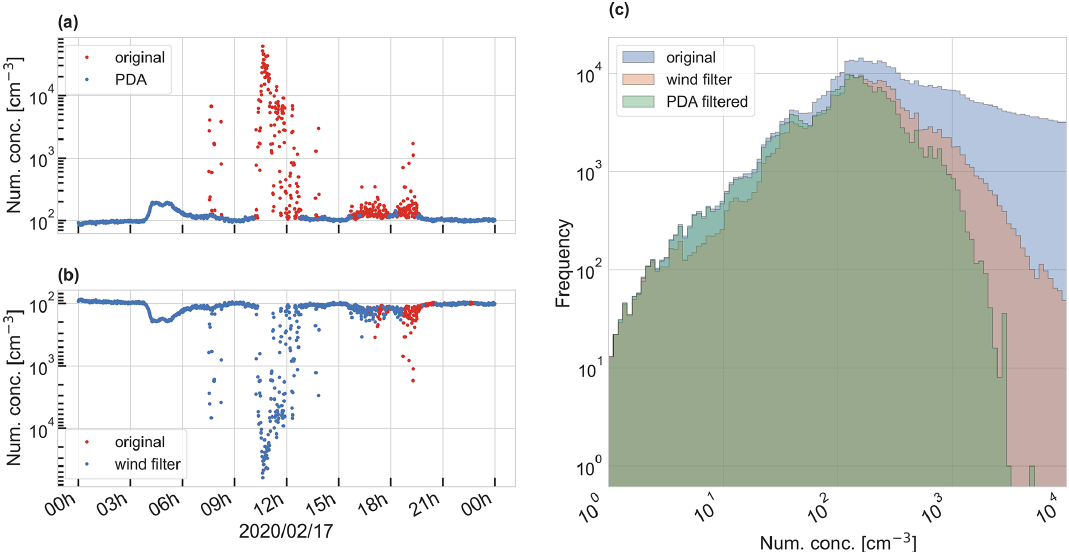
Figure 8. Comparison of the PDA (a) with the wind-based method, assuming a polluted-air sector of 90 to 270 ◦ from the bow ( b , mirrored). Both filtered time series (blue) are underlain with the original raw data (red). The wind-based filter method cannot detect pollution events coming from other directions than the given wind sector. Panel (c) shows histograms of particle number concentrations before (blue) and after application of the PDA (green) and the wind mask (red).